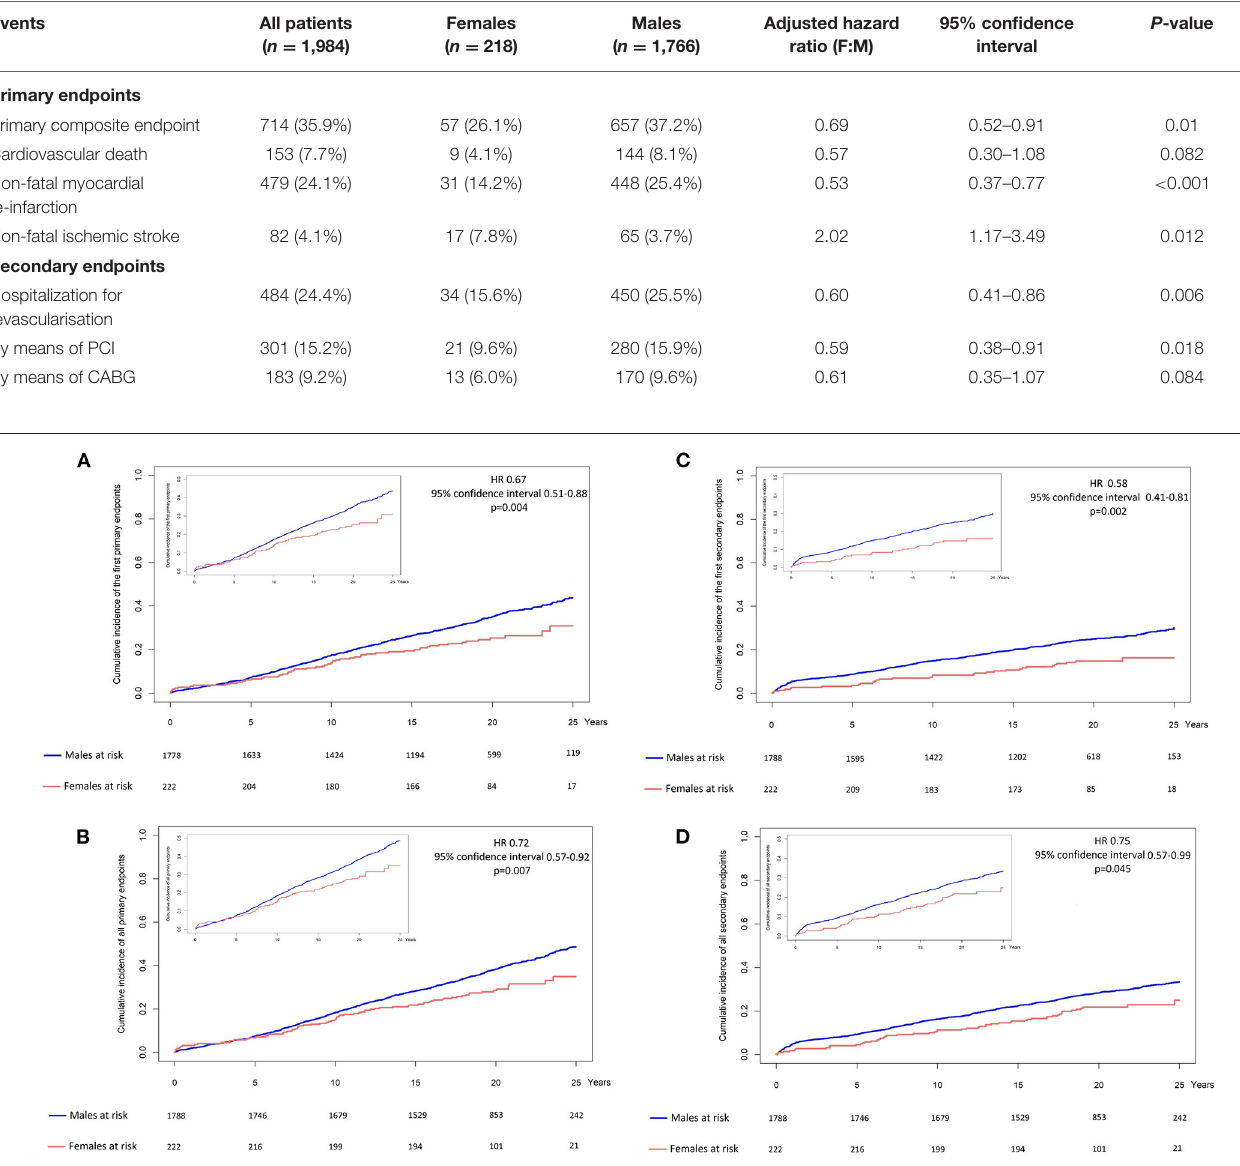
TABLE 2 | First occurrence of primary and secondary endpoints during follow-up by sex.